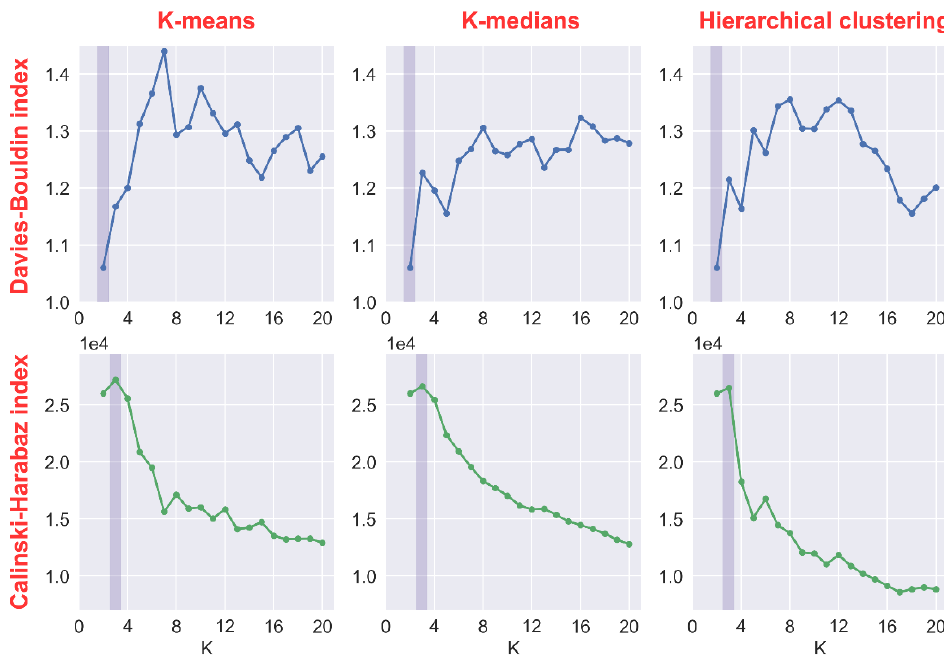
Figure 10. Optimal cluster number determined by Davies–Bouldin index (DBI) and Calinski–Harabaz index (CHI).